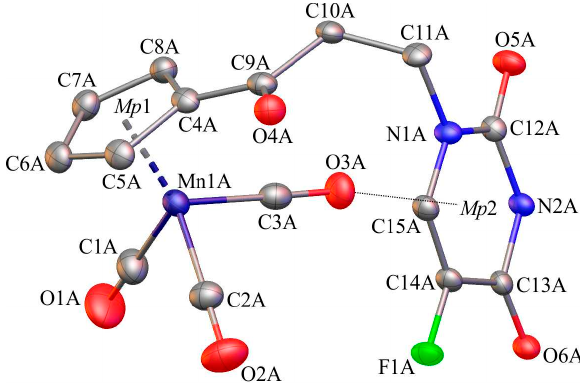
Figure 1. The molecular diagram of 1 with atomic displacement ellipsoids at the 50% probability level; Mp1 corresponds to the midpoint of the cyclopentadienyl ring. Hydrogen atoms have been omitted for clarity. Only molecule 1A is shown. Selected bond lengths [Å] and angles [ ◦ ]: Mn1(A)-C1(A),